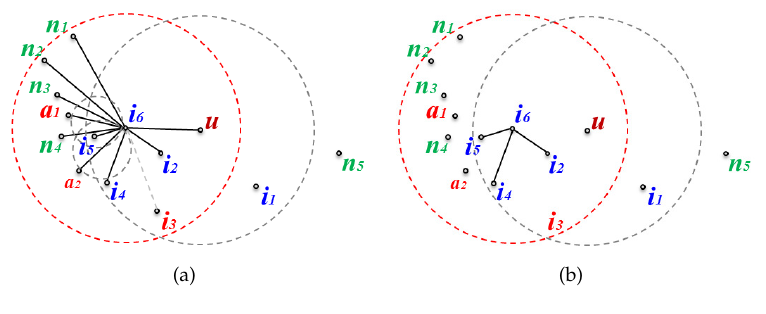
Figure 5. Topological changes that do not affect the planar graph: ( a ) changed local network graph, and ( b ) (a)’s planar graph.